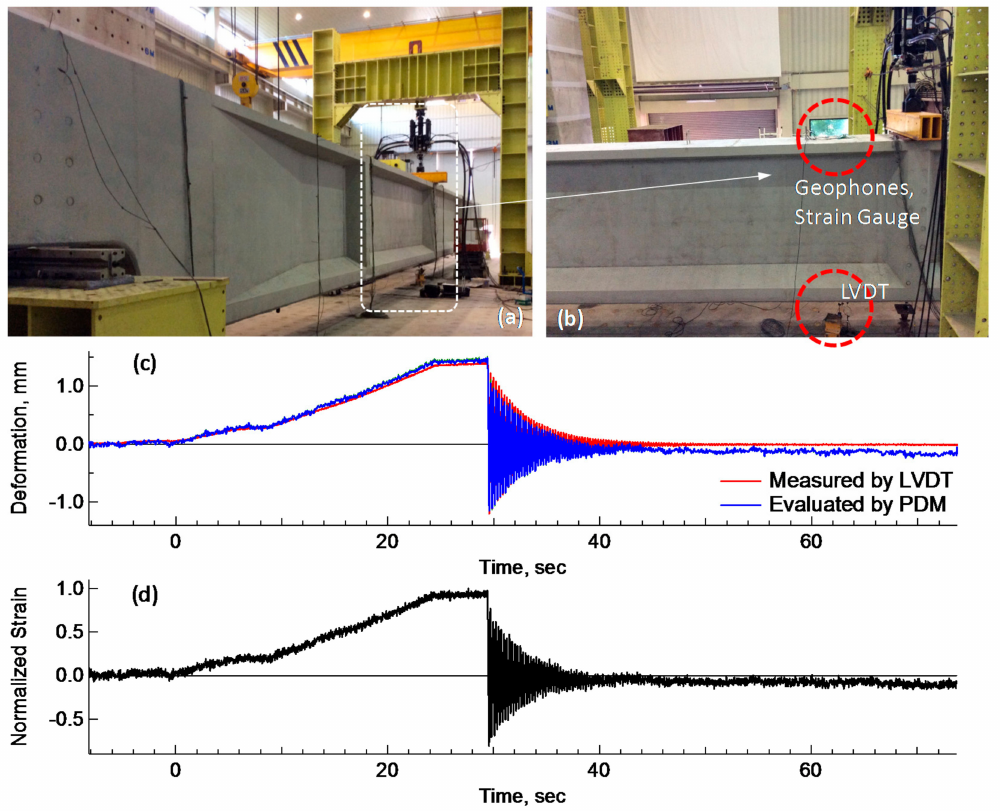
Figure 7. Comparison of PDM deflections and LVDT deflection in a laboratory test: ( a , b ) lab tests for deflection measurements; ( c ) comparison of PDM and LVDT Deflections; ( d ) strain